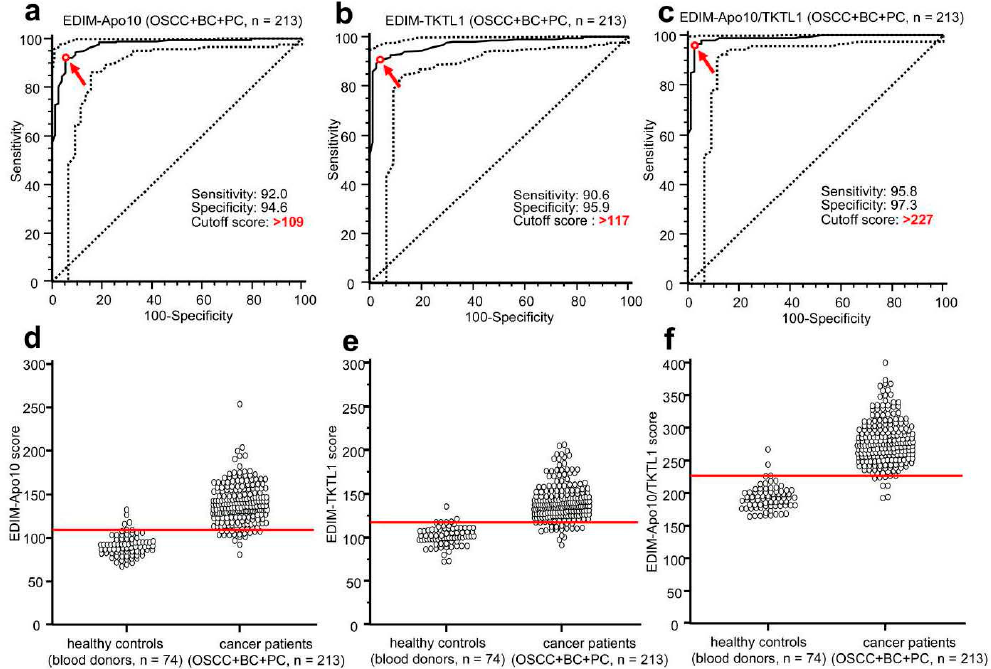
Figure 3. Receiver Operating Characteristics (ROC) analysis of epitope detection in monocytes (EDIM)-Apo10, EDIM-TKTL1, and combined EDIM Apo10/TKTL1 score in all cancer samples (OSCC, breast and prostate cancer, n = 213) compared with healthy individuals ( n = 74). The true positive rates (sensitivity) are plotted in functions of the false positive rate (100-specificity) for measurement of the cut-off point: ROC analysis for the diagnosis of all cancer samples/entities (OSCC, breast and prostate cancer, a – c ) shows calculated cut-off value with highest diagnostic accuracy (arrows) of EDIM-Apo10 ( a ), EDIM-TKTL1 ( b ), and combined EDIM Apo10/TKTL1 ( c ) score ( a , EDIM-Apo10 score >109: sensitivity 92.0%, 95% confidence interval (CI) 87.5–95.3%, specificity 94.6%, 95% CI 86.7–98.5%; b , EDIM-TKTL1 score >117: sensitivity 90.6%, 95% CI 85.9–94.2%, specificity 95.9%, 95% CI 88.6–99.2%; c , combined EDIM-Apo10 plus EDIM-TKTL1 score >227: sensitivity 95.8%, 95% CI 92.1–98.0%, specificity 97.3%, 95% CI 90.6–99.7%). Dotted lines show 95% CI. OSCC, oral squamous cell carcinoma; BC, breast cancer; PC, prostate cancer. In the interactive dot diagrams (part of ROC curve analysis, d – f ), the data of healthy controls and cancer group are displayed as dots on two vertical axes. The horizontal line indicates the cut-off points with the best separation/highest accuracy (minimal false negative and false positive results) between healthy controls and cancer group. The corresponding test characteristics sensitivity and specificity are shown above. Figure published in [2, additional file 13].